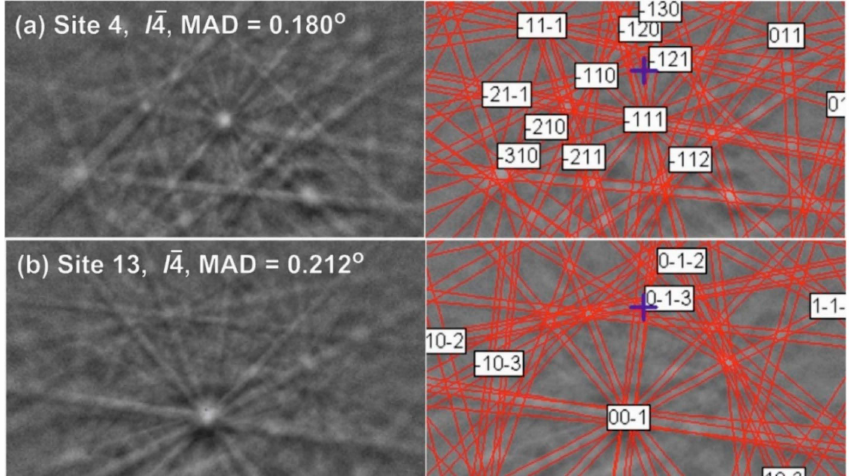
Figure 7. Representative EBSD patterns from (Fe,Ni) 3 (P,S), indexed with the schreibersite-type structure shown in Figures 2 and